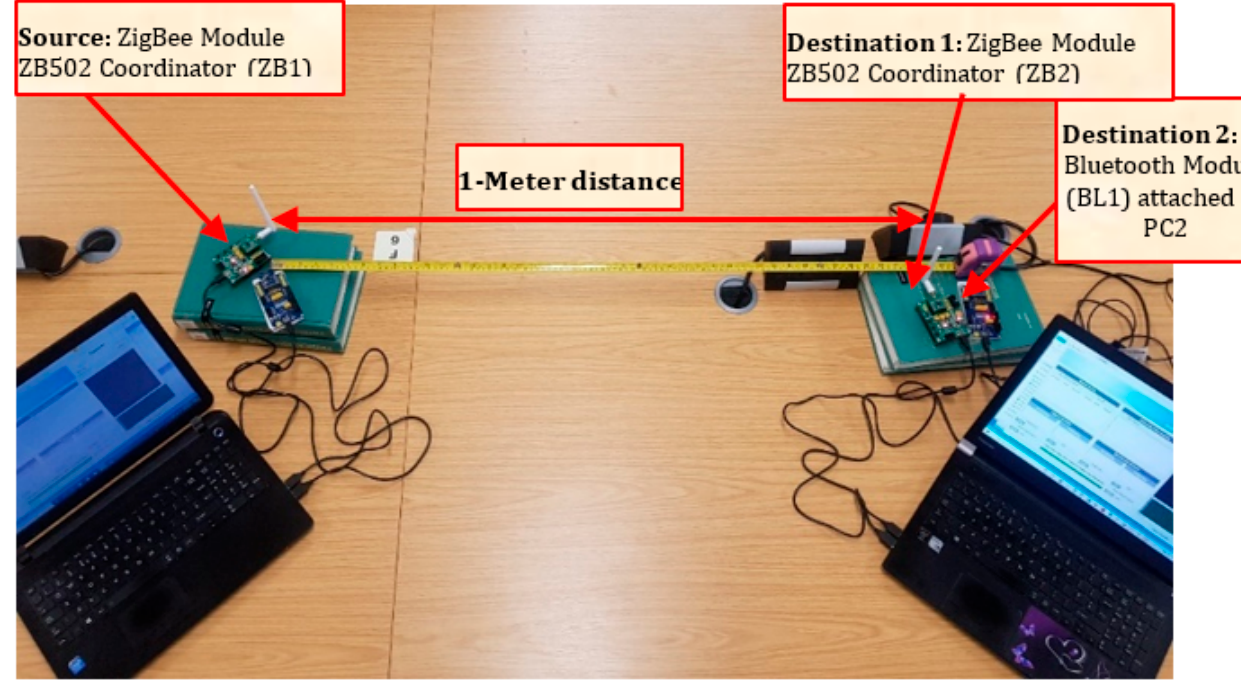
Figure 5. Respective Connection of Module Devices (ZB1 source and BL2 and ZB2 destinations) to PC1 and PC2.